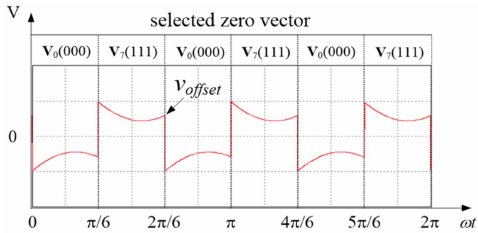
Figure 4. Zero voltage vector selection according to the o ff set voltage.